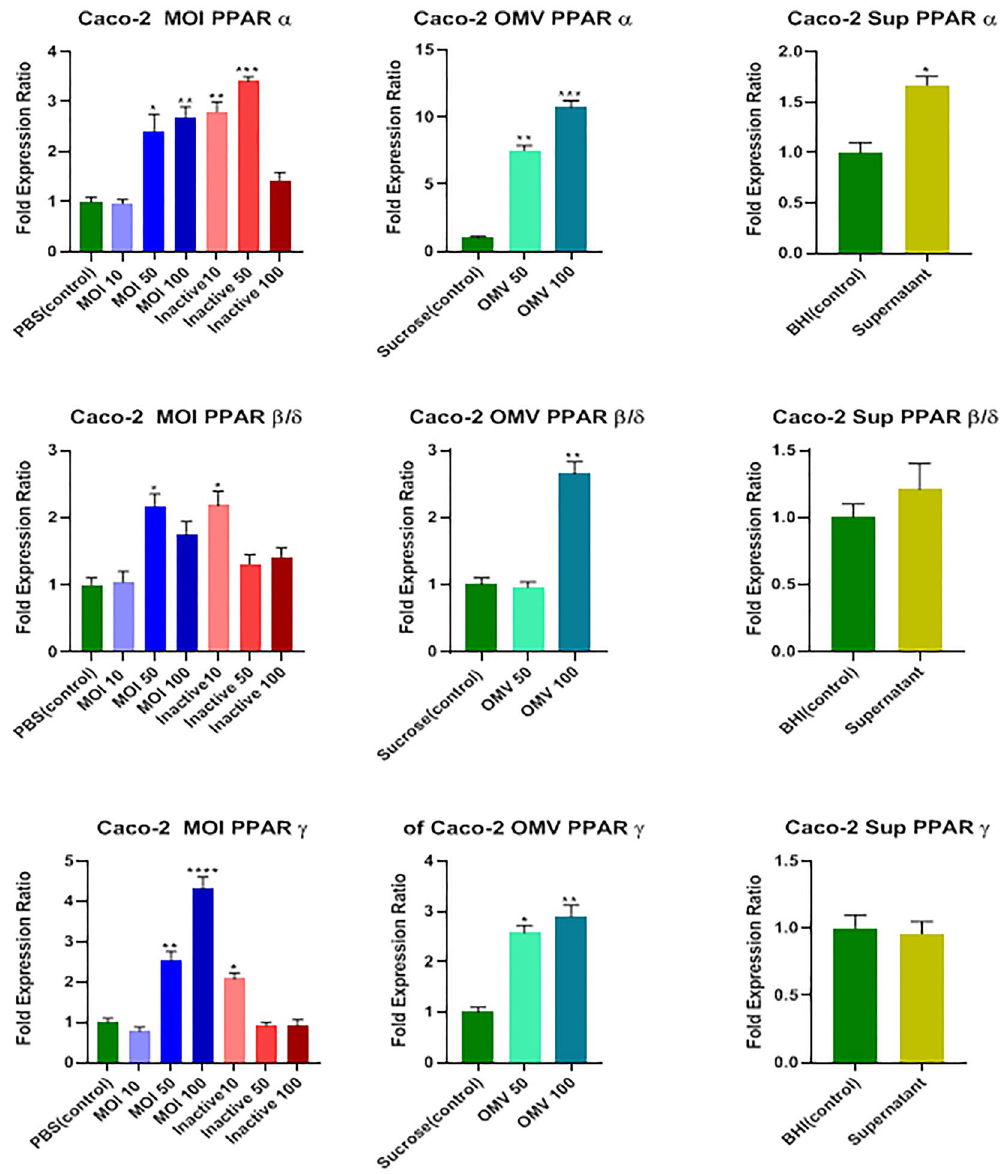
Figure 3. Effects of active and inactive A.muciniphila (at MOIs of 10, 50, and 100), its derived OMVs (50 and 100 μg/mL) and 7% (v/v [medium/cell-free supernatant]) cell free supernatant on the expression of PPARS (α, β/δ, and ϒ ) genes in Caco-2 cells. Significancy is evaluated in comparison with control. Data are shown as the mean ± SEM. (*) and ( # ) represent significant increase and decrease, respectively.* P < 0.05, ** P < 0.01, *** P < 0.001, and **** P < 0.0001 by one-way ANOVA and t-test statistical analysis. MOI: multiplicity of infection, OMV: outer membrane vesicle, Sup: